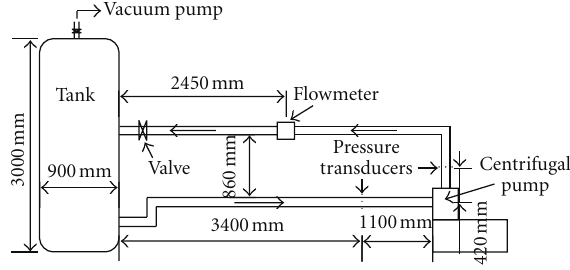
Figure 2: The main dimensions of the pump test